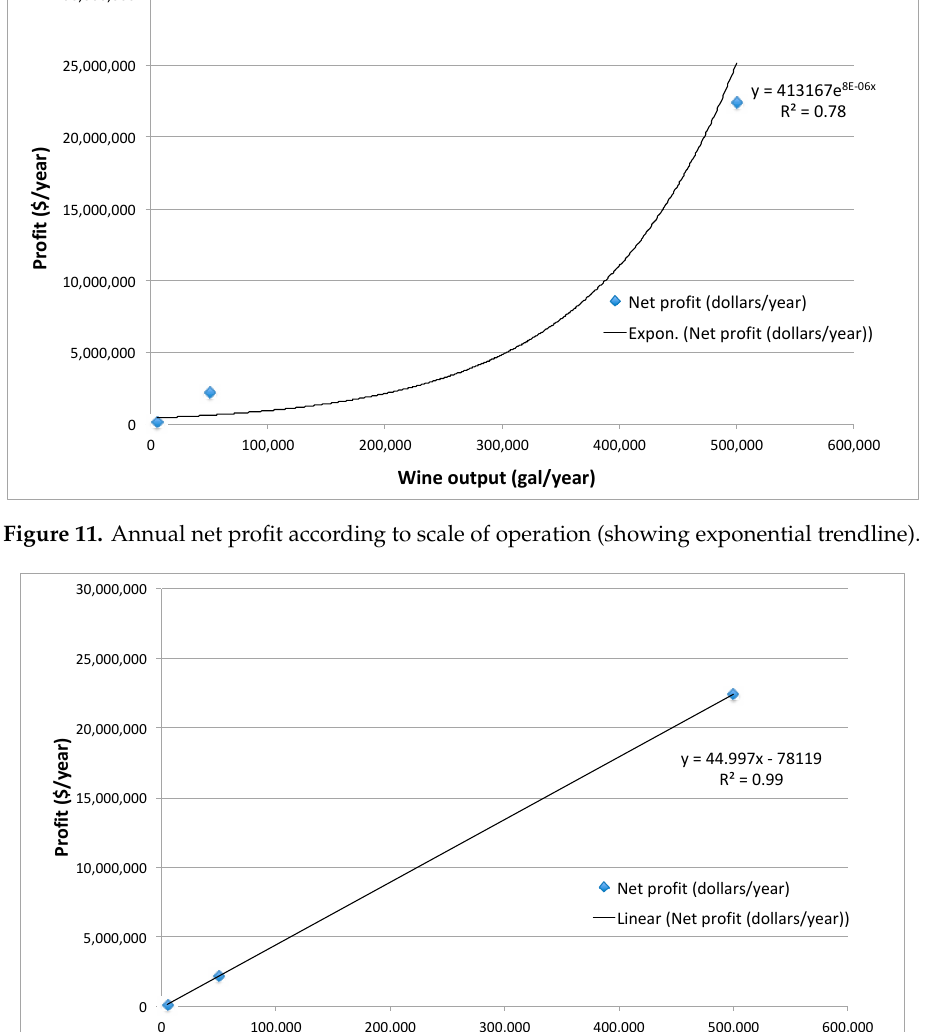
Figure 10. Annual net profit according to scale of operation.